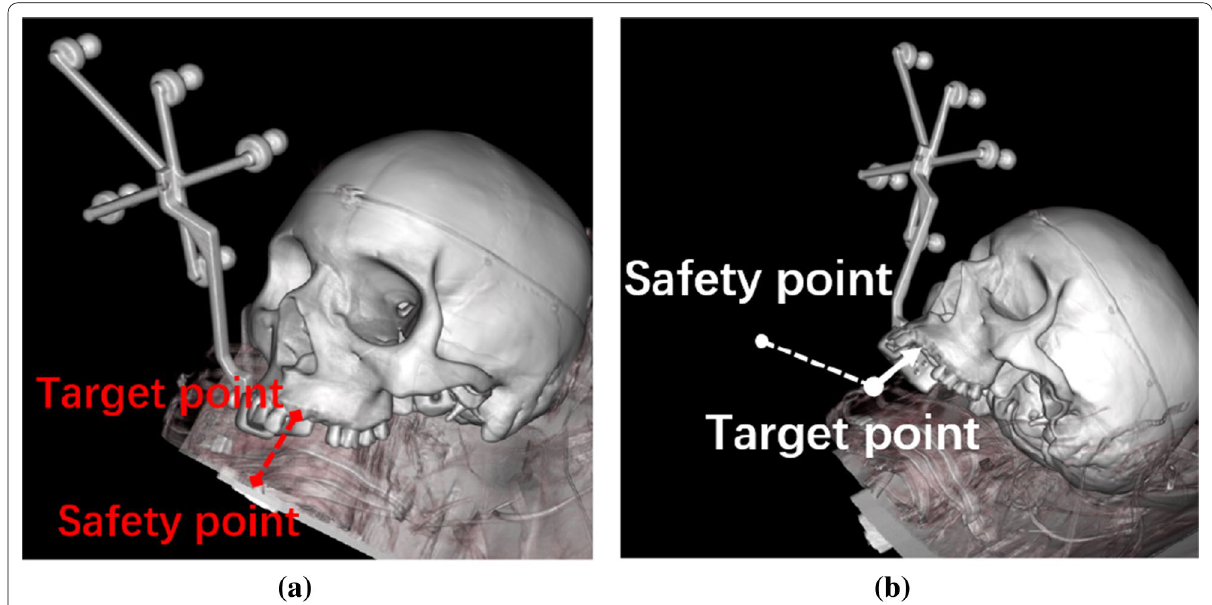
Figure 8 Surgical path planning: a Automatic positioning method, set the target on the alveolar bone, b Auxiliary positioning method, set the target point outside the alveolar bone